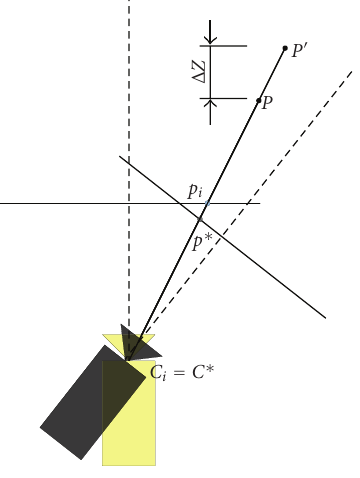
Figure 3: Rotation of the camera.